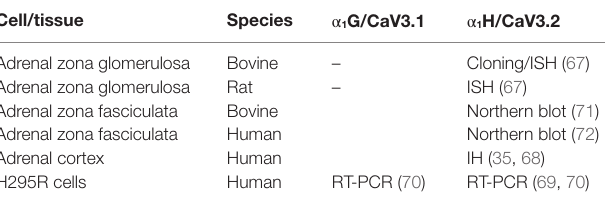
TABLe 2 | Adrenal cortex expression of T-type calcium channel isotypes. Cell/tissue